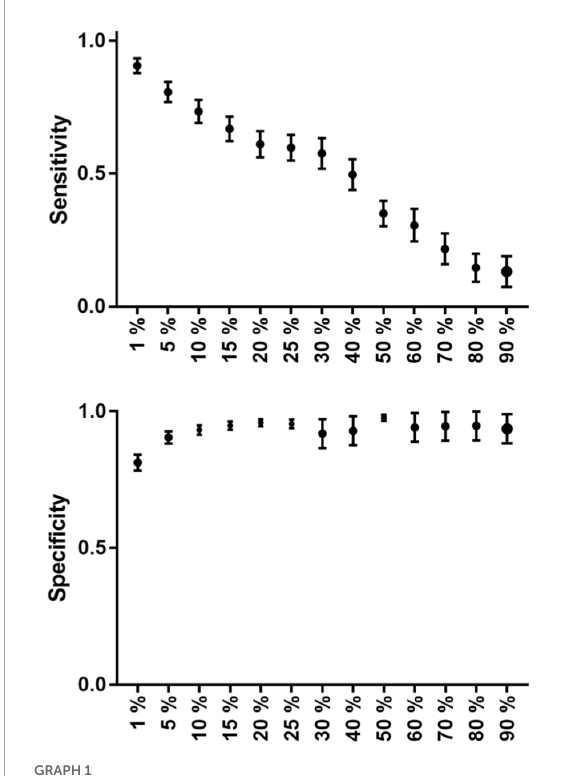
GRAPH1 The group average sensitivity and specificity values (with standard error of mean) can be seen on this graph at each threshold level. Sensitivity decreases in a nearly linear fashion, while specificity has a nearly parabolic increase along the increasing threshold